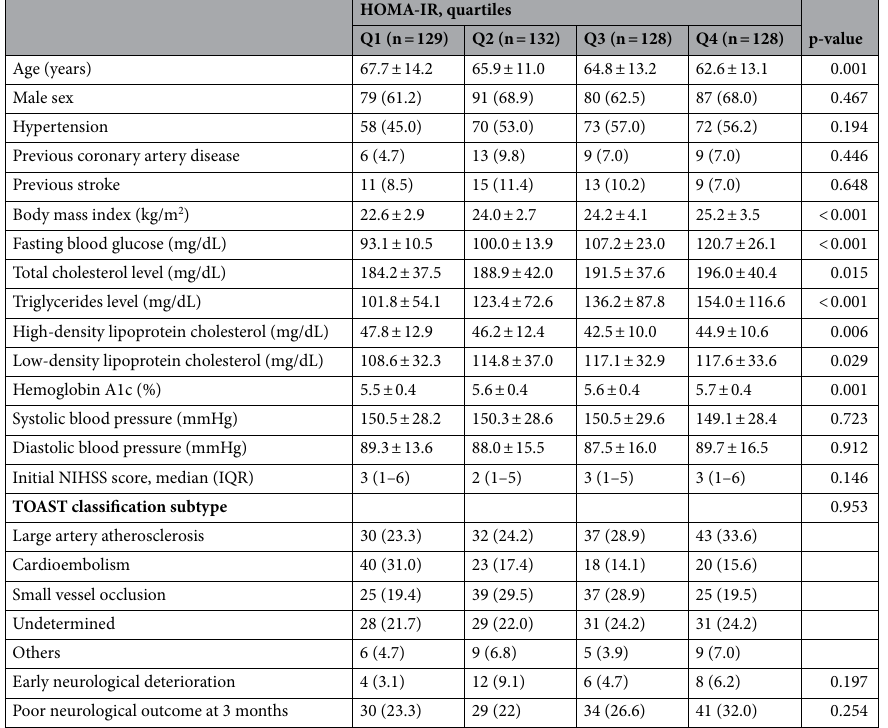
Table 1. Baseline characteristics according to log homeostasis model assessment of insulin resistance scores quartiles. Data are expressed as the mean ± SD, or n (%). HOMA-IR, homeostasis model assessment of insulin resistance scores; NIHSS, National Institutes of Health Stroke Scale (NIHSS); IQR, interquartile range; TOAST, the Trial of Org 10,172 in Acute Stroke Treatment.